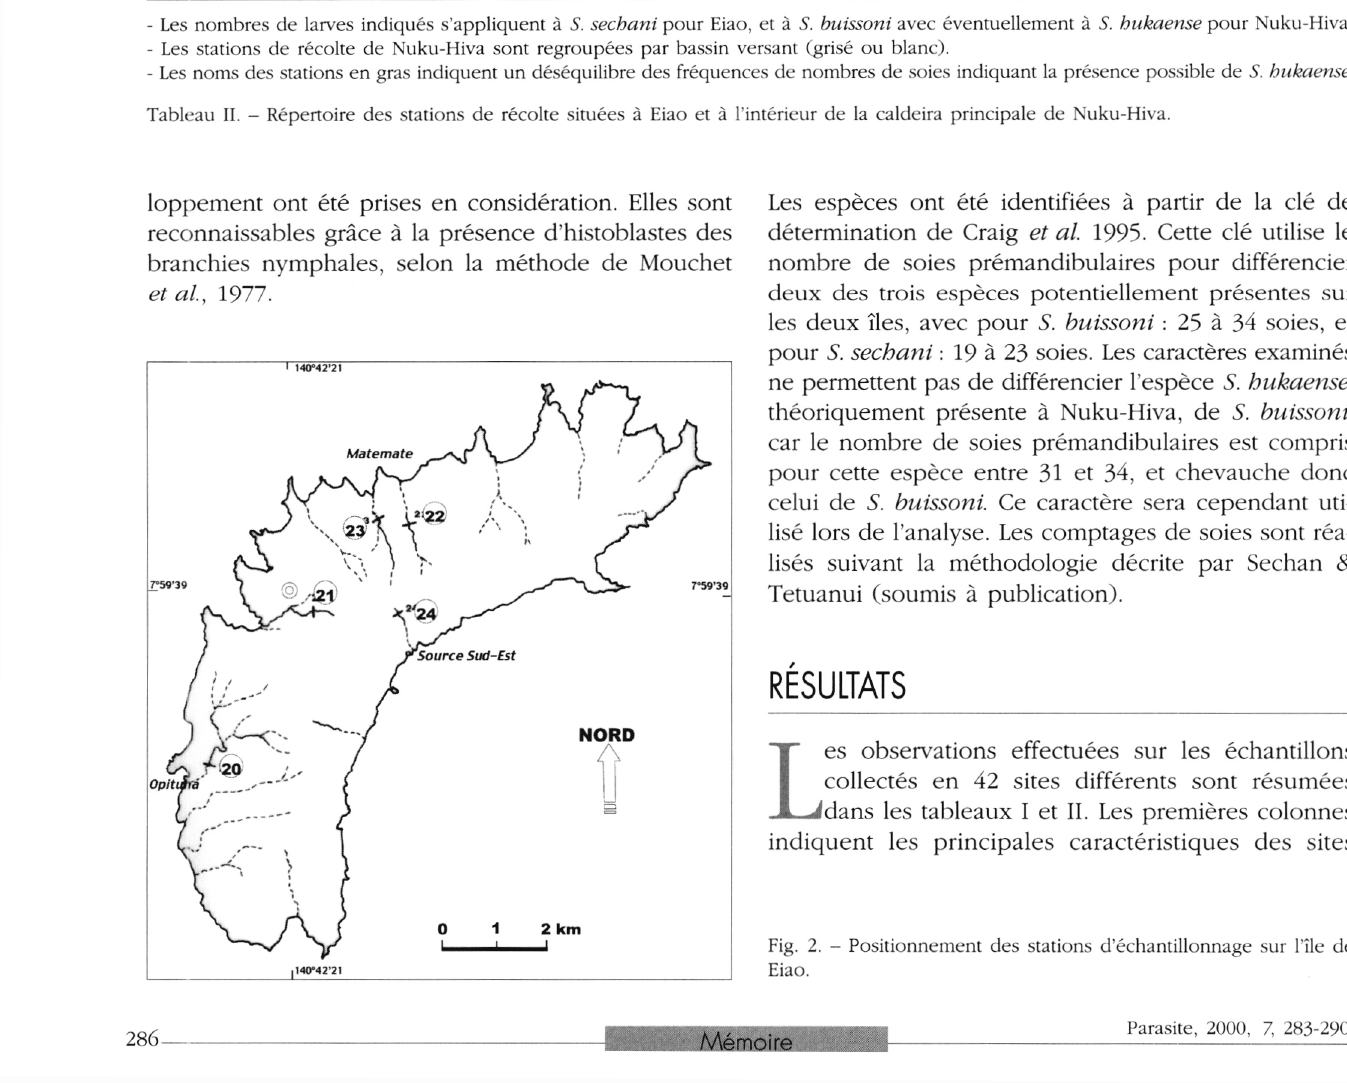
Fig. 2. - Positionnement des stations d’échantillonnage sur l’île de